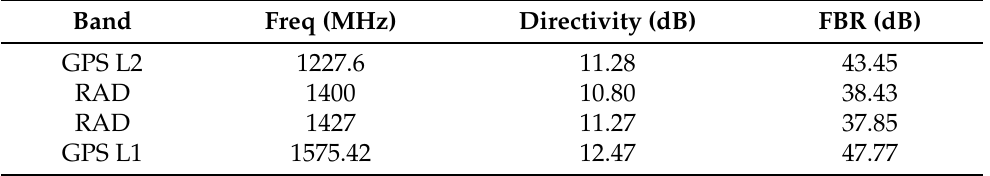
Table 9. Measurements of the antenna with infinite ground plane.